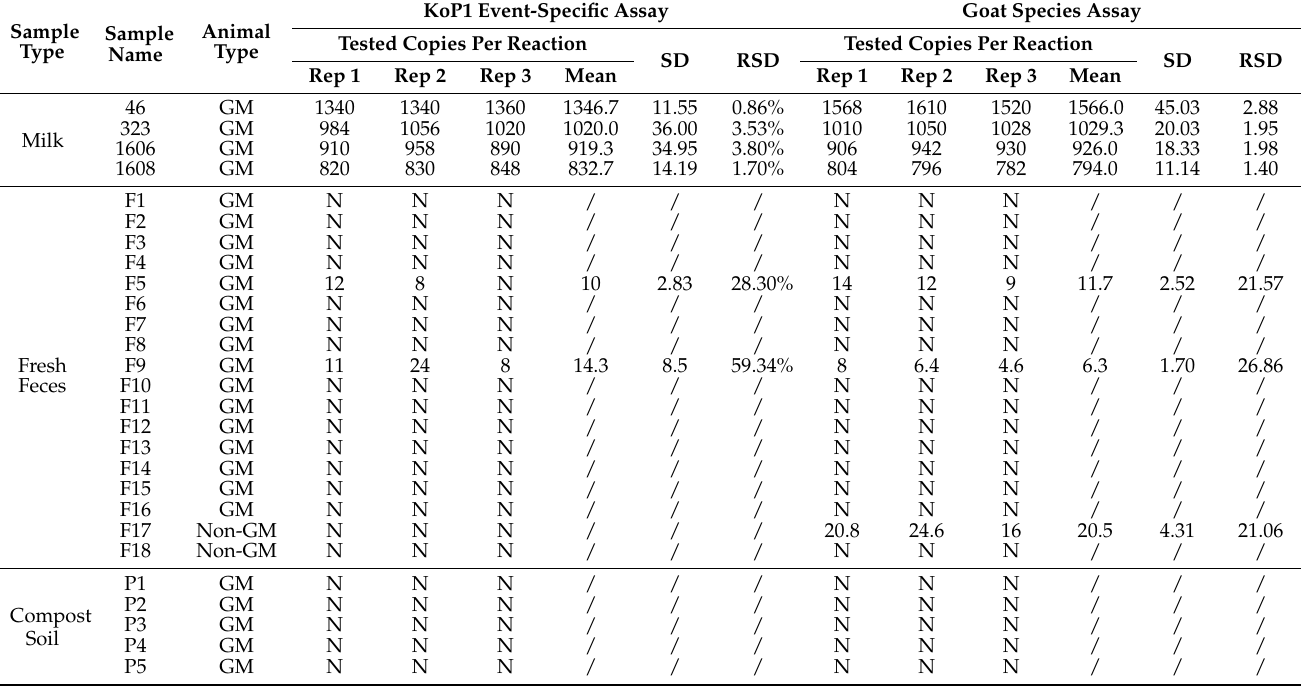
Table 5. Detection of practical blood, fecal, and soil samples using the developed event-specific ddPCR